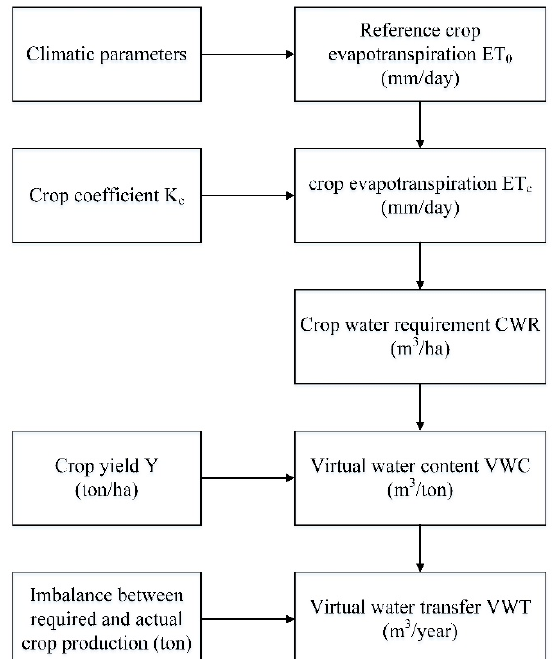
Figure 2. Procedures in calculating the virtual water flows (adopted from Liu et al. (2015) [22]).